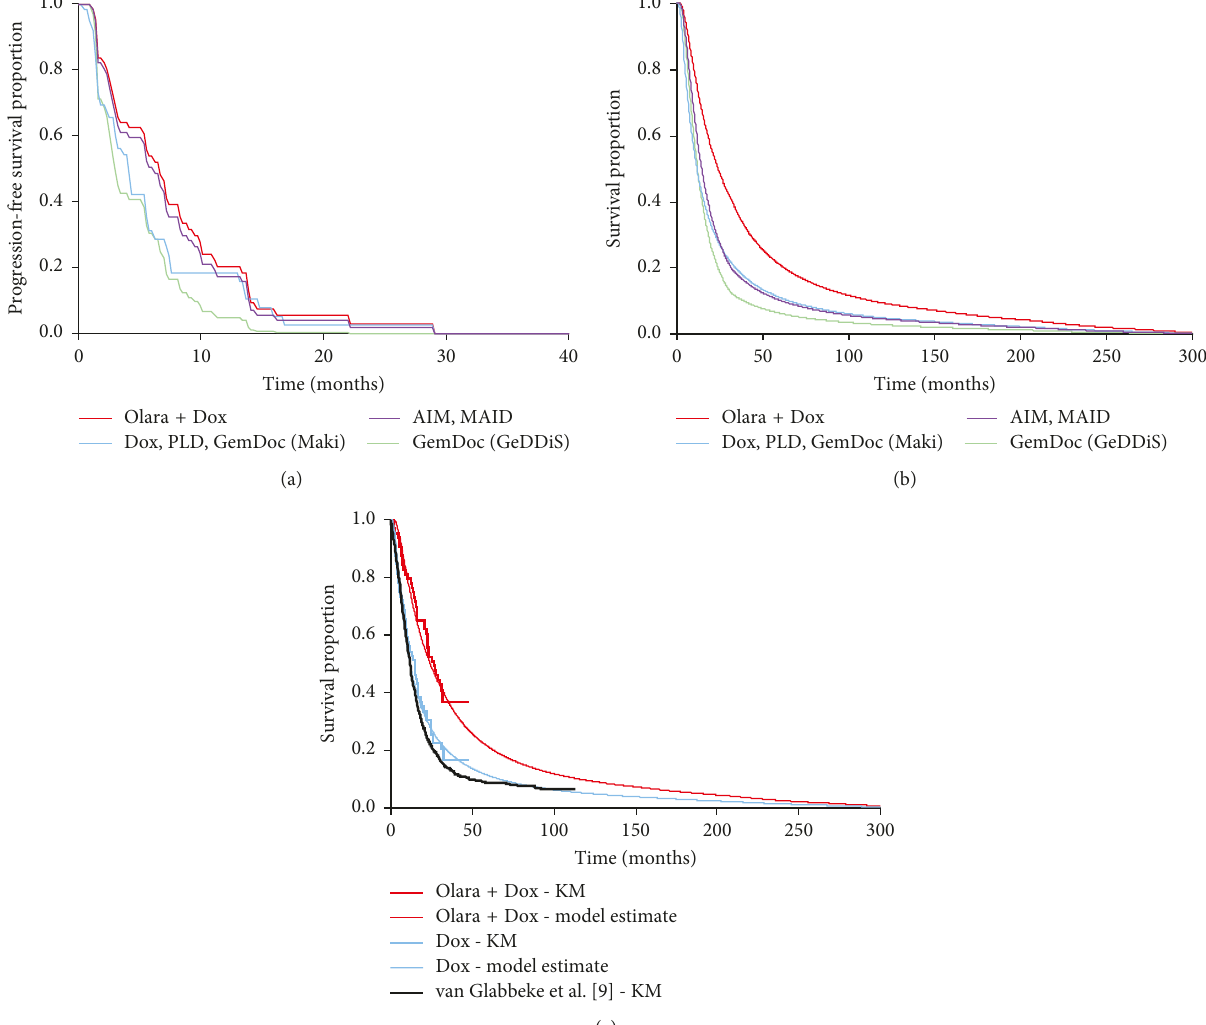
ifosfamide+doxorubicin+ (cid:31)